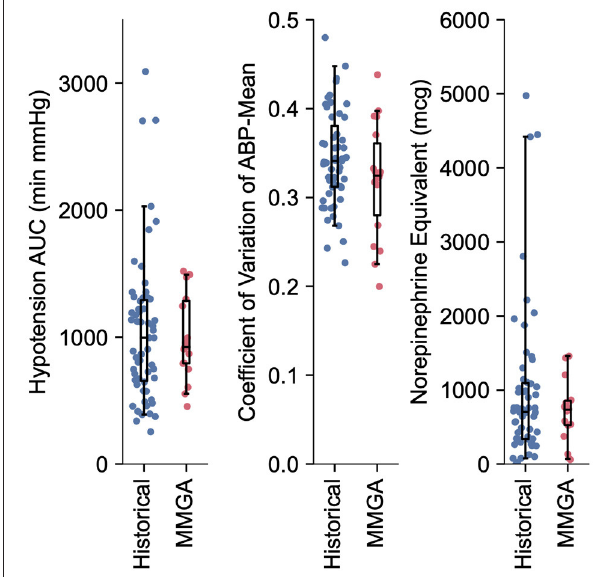
TABLE 2 | Demographics of study cohorts.